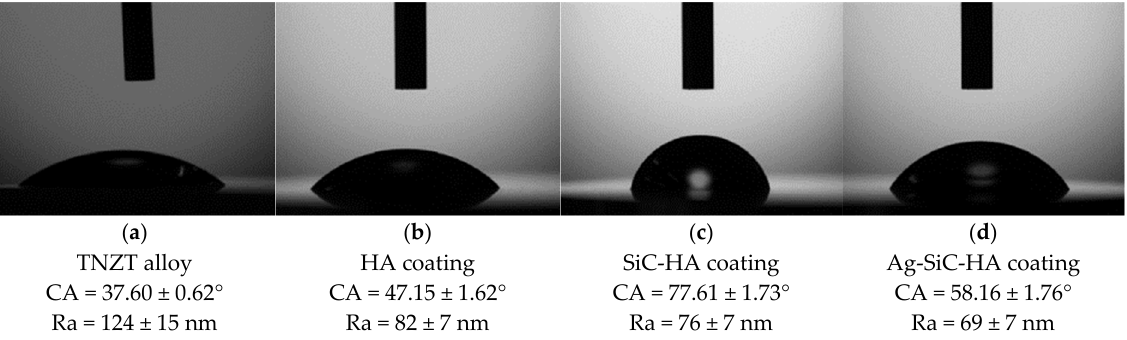
Figure 7. Images of the SBF droplets on the surfaces, the measured values of the contact angle (CA) and average roughness parameter (Ra) for the TNZT alloy ( a ) and three types of coatings: HA ( b ), SiC-HA ( c ) and Ag-SiC-HA ( d ).